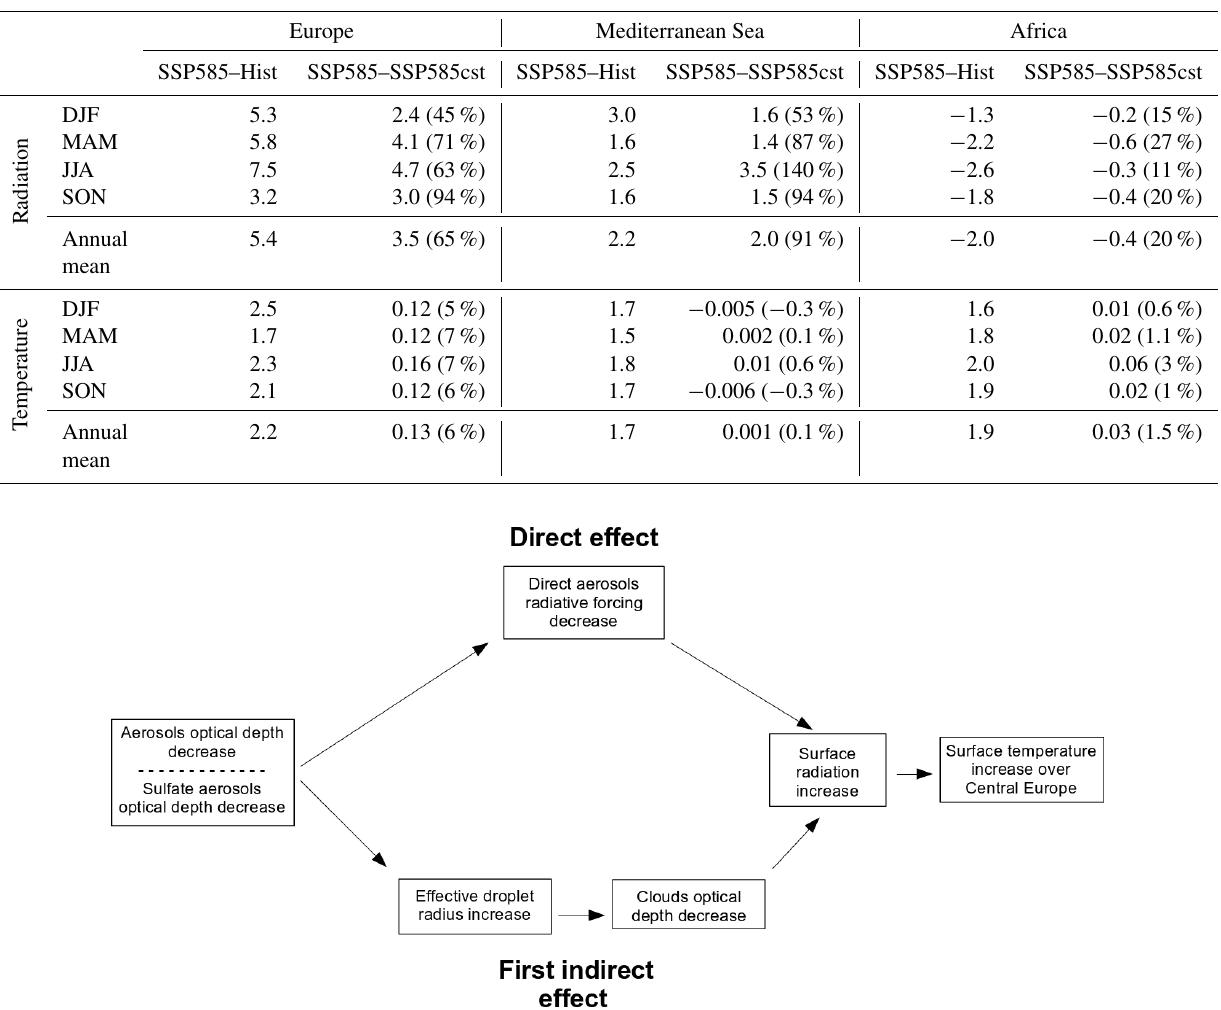
Figure 15. Summary of the anthropogenic aerosol role on the projected surface temperature increase over Central Europe in summer between the periods 1971–2000 and